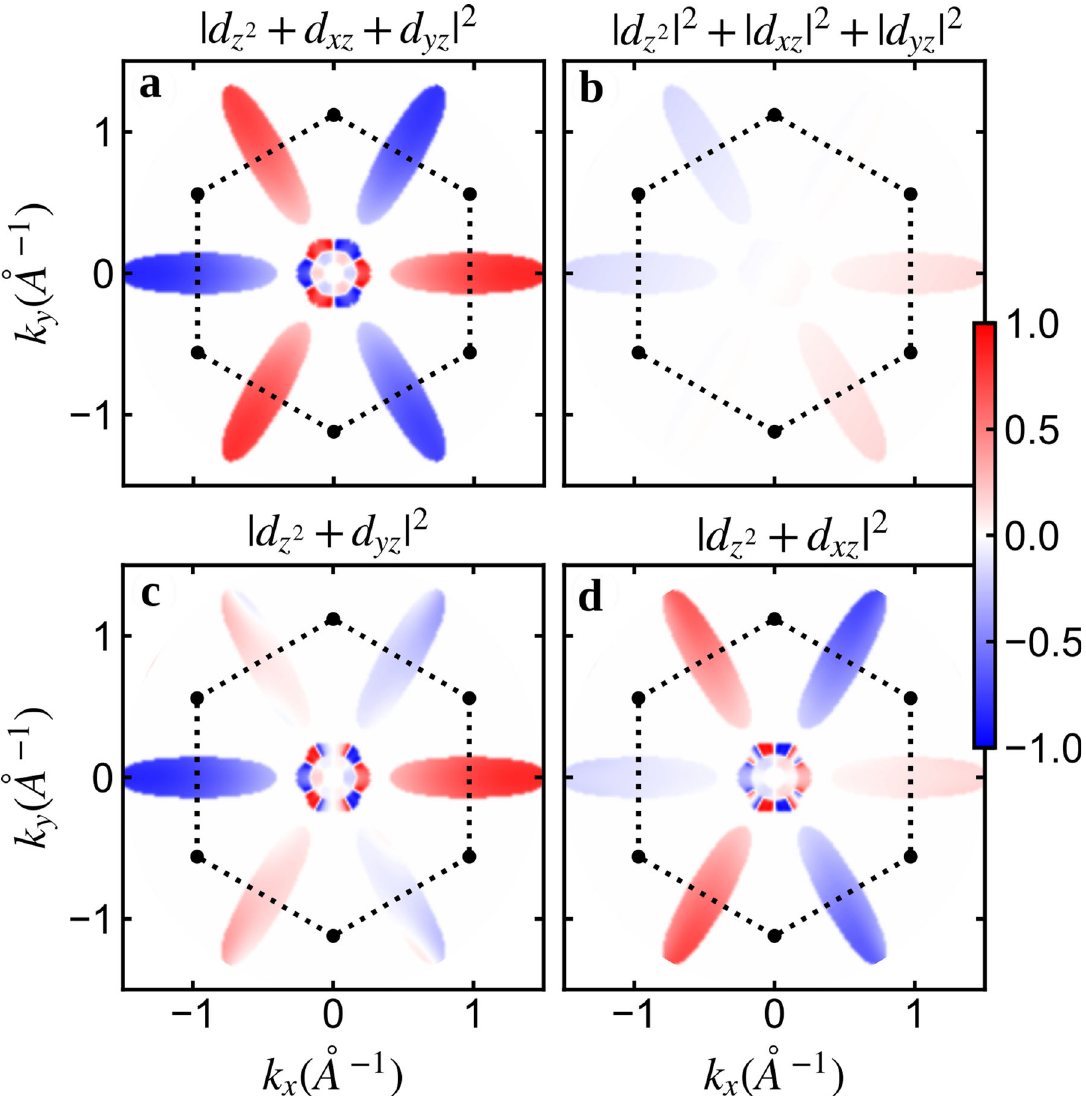
Fig. 6 Role of orbital mixing in photoemission. a i LDAD calculated using the TB + PW model where the initial state is composed of a coherent superposition of d z 2 , d xz and d yz orbitals. b Same as ( a ), for the initial state being an incoherent sum the signal including the d z 2 , d xz or d yz orbitals. c Same as ( a ) but including only d z 2 and d yz orbitals. d Same as ( a ) for the initial state being a coherent combination of d z 2 , and d xz orbitals. The binding energy in all plots is fi xed at E B = − 0.05 eV; the photon energy is ℏ ω = 21.7 eV as in the